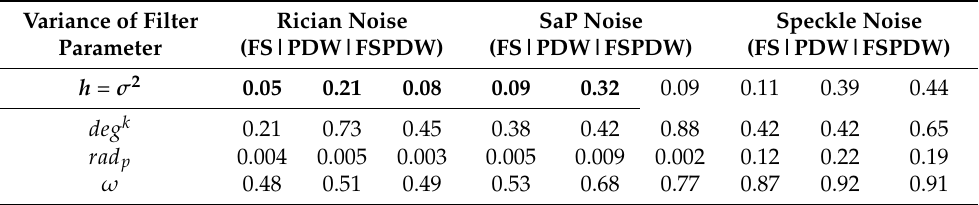
Table 3. Analysis of variance of optimized filter’s parameter for individual datasets and additive